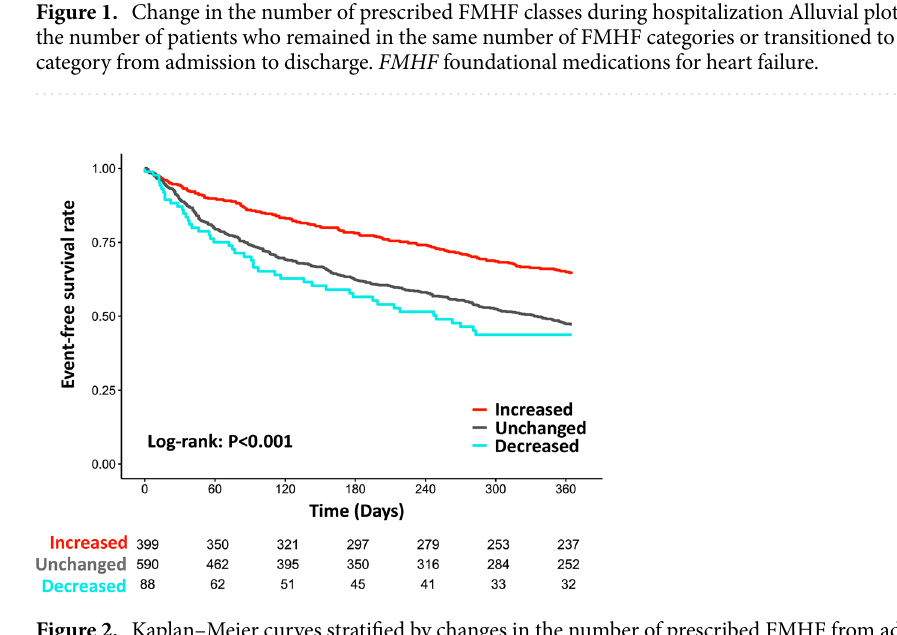
Figure 2. Kaplan–Meier curves stratified by changes in the number of prescribed FMHF from admission to discharge. There was a significant difference in survival rates between the three groups (log-rank P < 0.001). FMHF foundational medications for heart